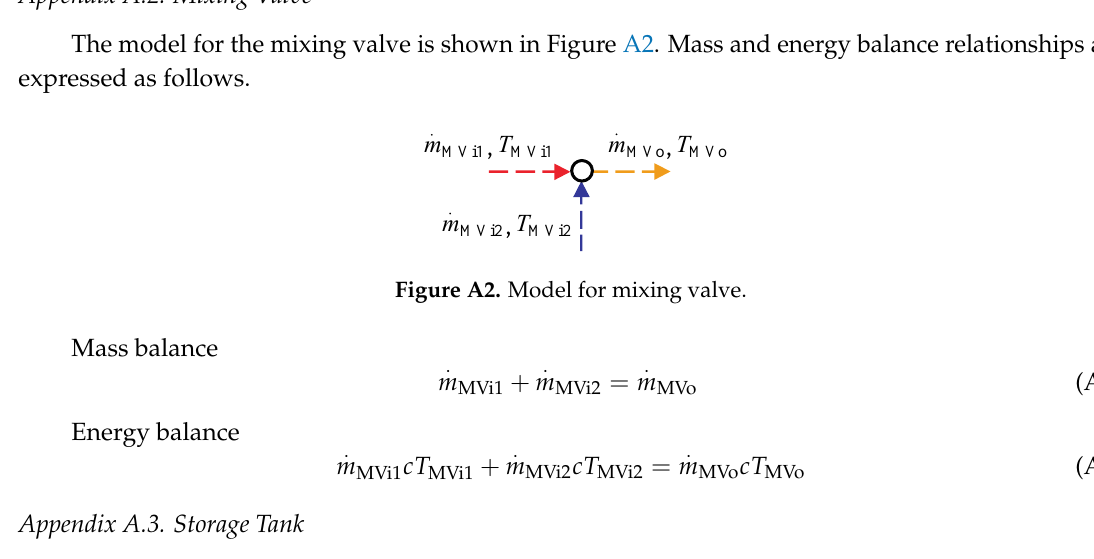
Figure A1. Model for CO 2 heat pump. Mass Balance